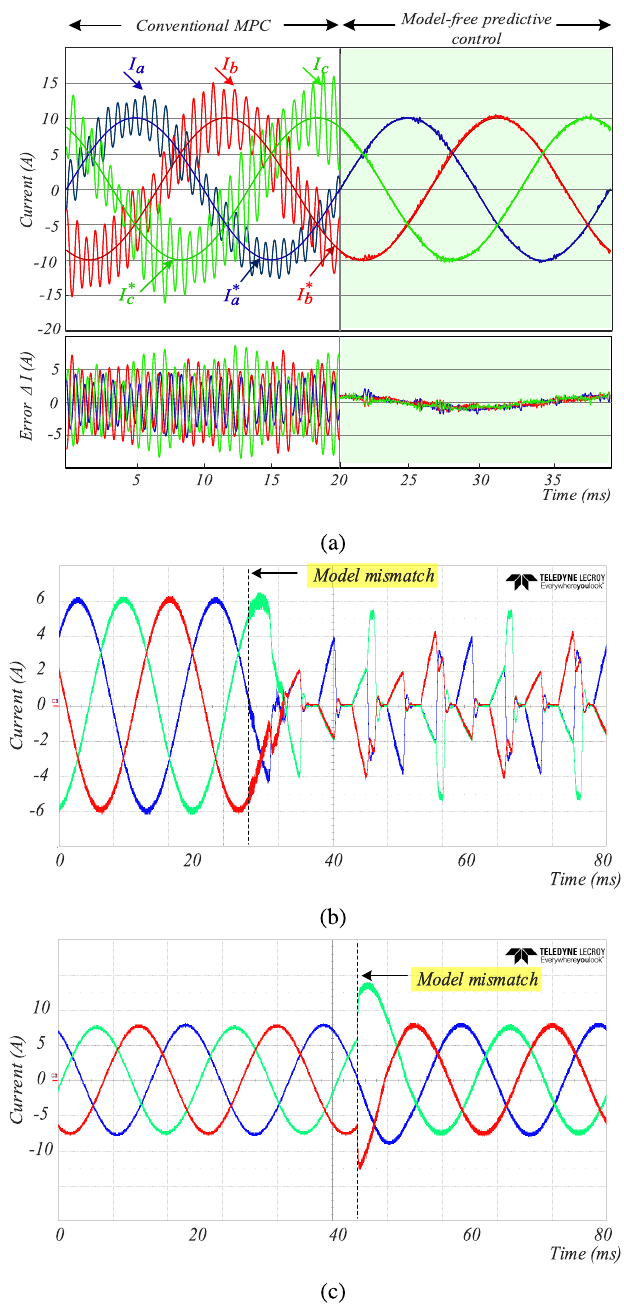
FIGURE 12. Performance comparison of conventional FCS-MPC and the Figure 10. Performance comparison of FCS proposed MF-PC of a voltage source inverter considering model mismatch. ( b ) MPC performance. ( c ) MFPC mismatch. (a) Simulated comparison between the conventional FCS-MPC and the proposed MF-PC. (b) Experimental validation of the conventional FCS-MPC. (c) Experimental validation of the proposed MF-PC.